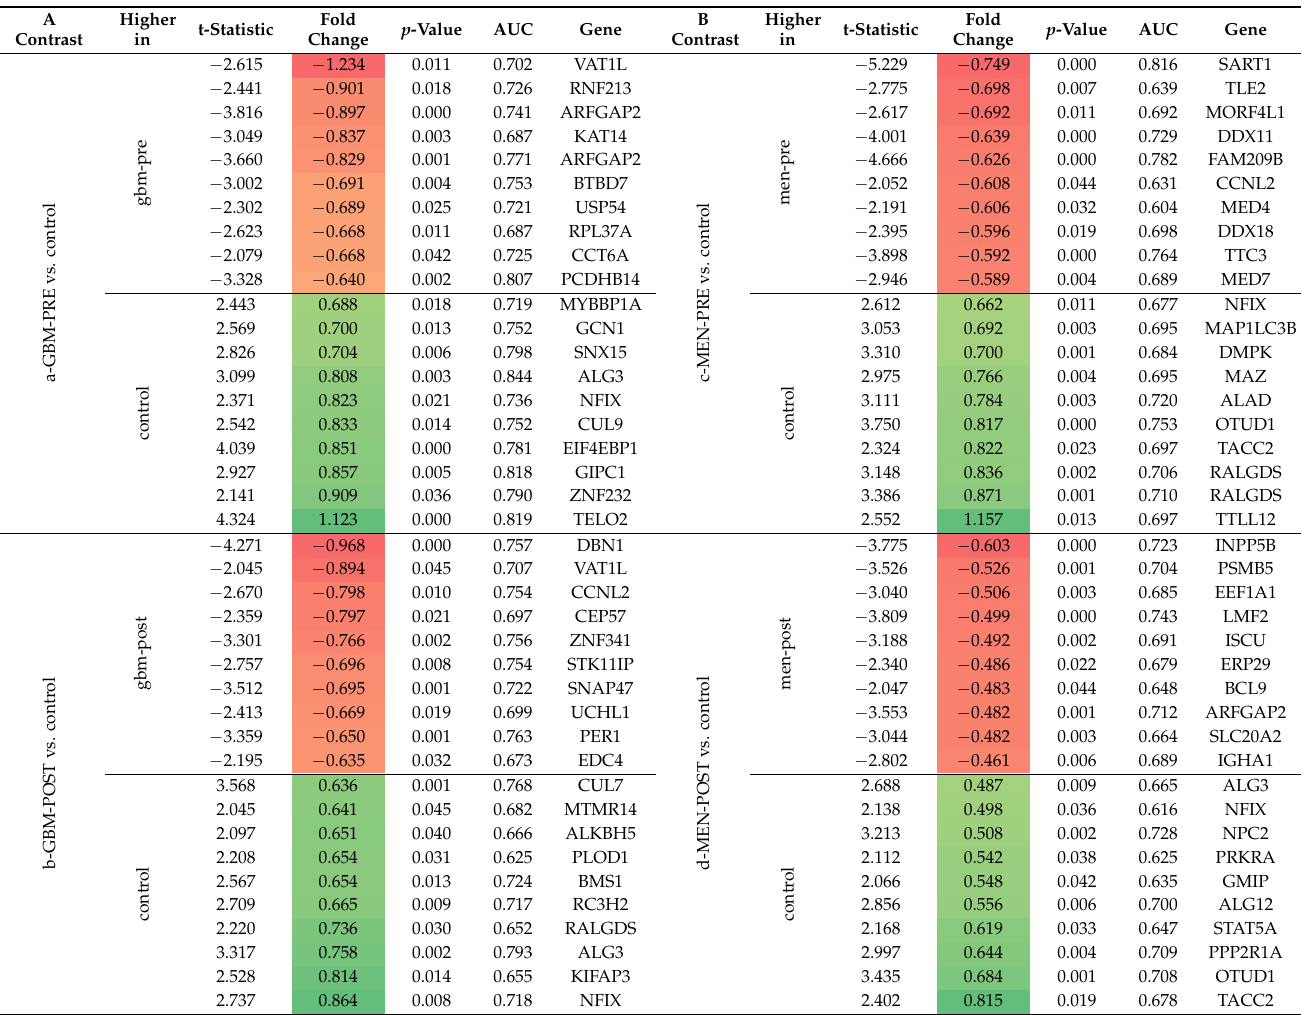
Table 1. Toptables of DIRAGS in (A) glioblastomas (contrasts (a,b,e)) and (B) meningiomas (contrasts (c,d,f)). Antigens are sorted by the fold change reactivity between classes, and the top 10 antigens of both classes for each contrast are indicated with t-statistics, p -values and AUC values. Gene symbols are indicated. Complete lists of DIRAGs are given in Supplementary Table